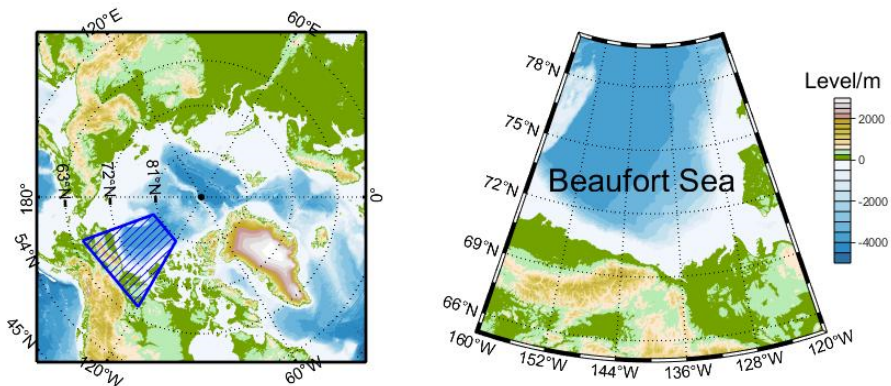
Figure 3. Research area.